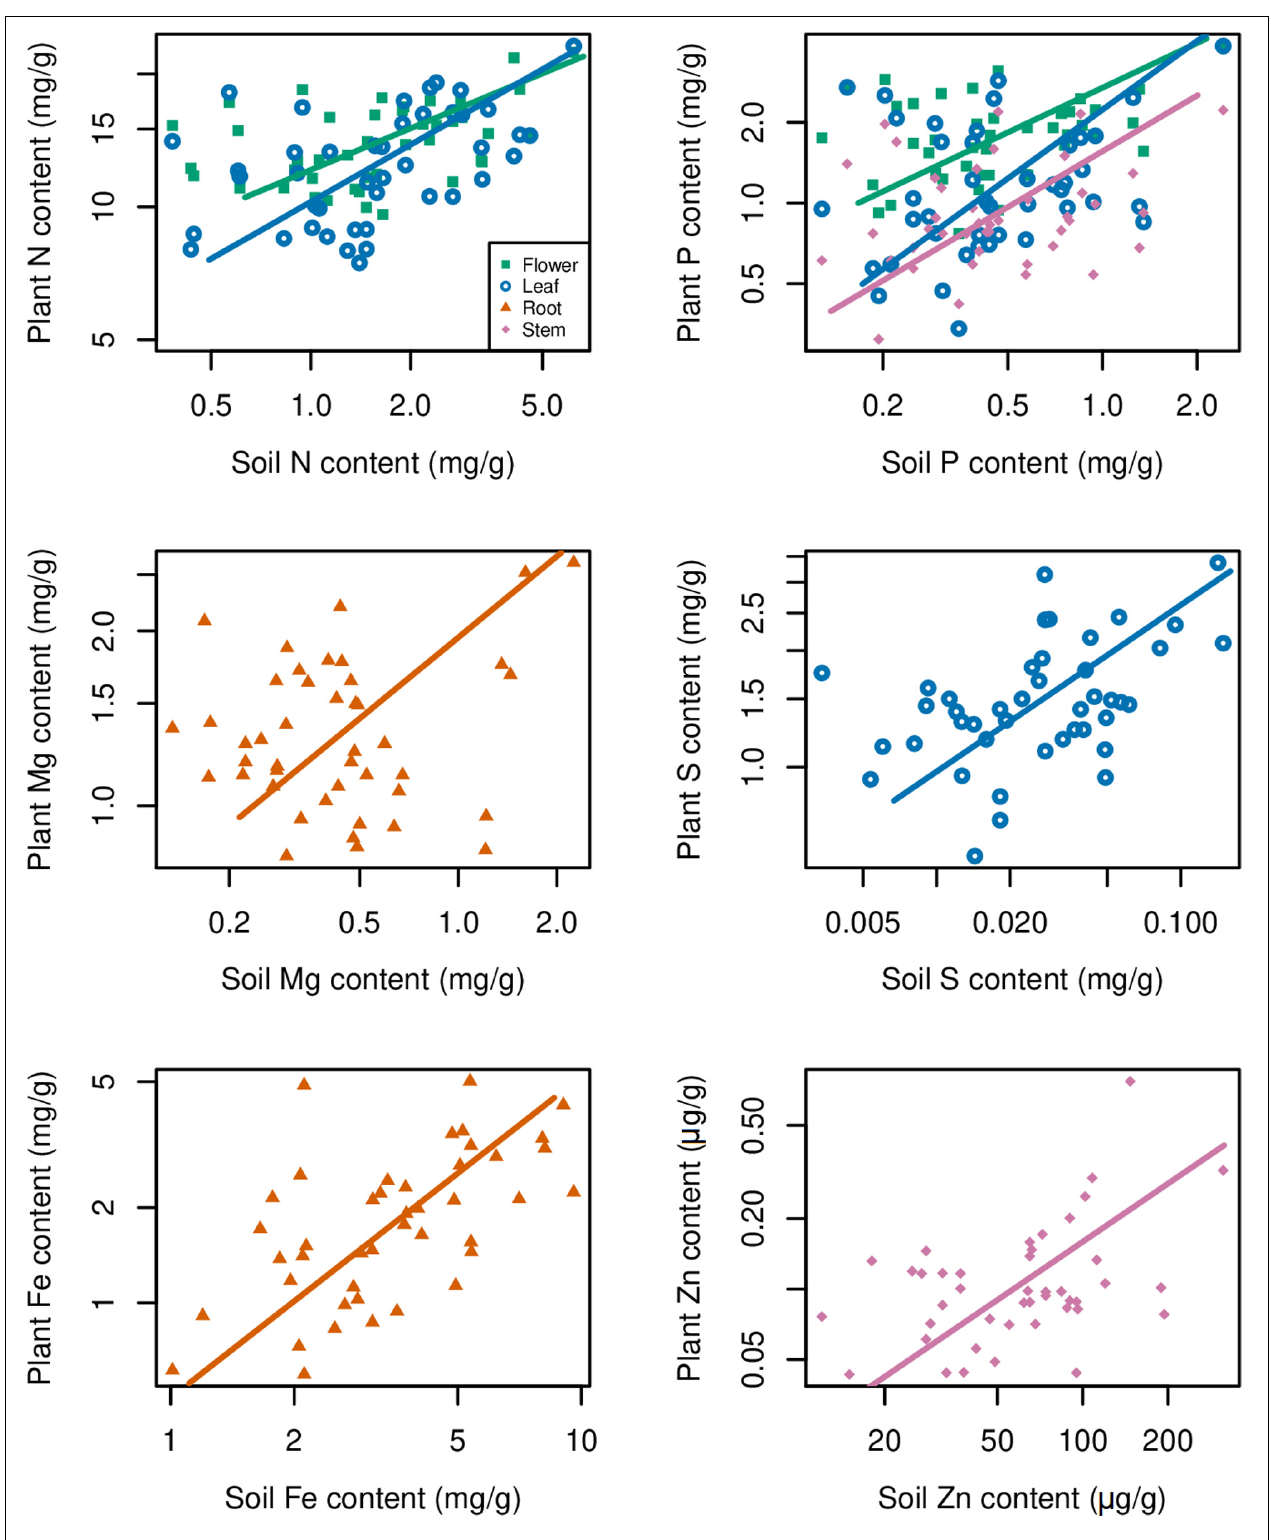
FIGURE 6 | Relationships between soil elements contents and plant elements contents. A base-10 logarithmic scale is used for the axes. The sample size is 43 for both soil and each plant organ, p < 0.01.